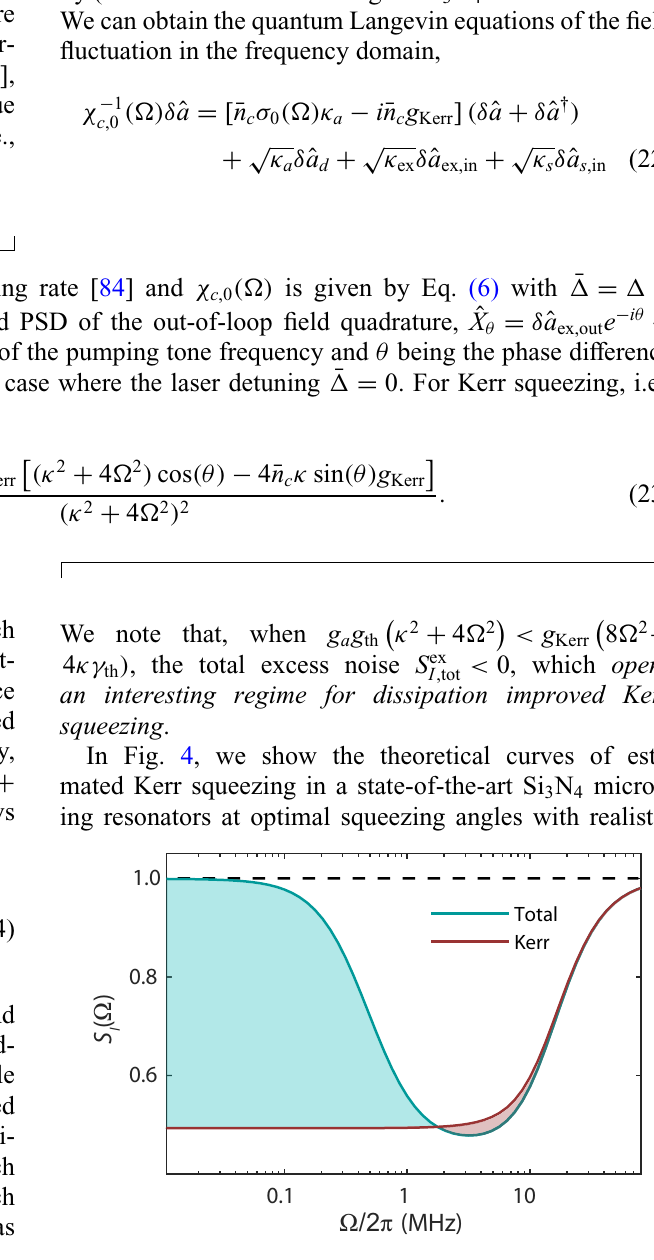
FIG. 4. Estimated Kerr squeezing with dissipative dynamics at optimal angles in a Si 3 N 4 microcavity. The noise spectral den- sity is normalized to the shot noise floor (black dashed line). The red curve corresponds to the case where the dissipative dynamics is absent, while the green curve corresponds to the case where Kerr nonlinearity and dissipative dynamics coexist. The green and red shade areas correspond to the excess noise and improved squeezing due to dissipative feedback. (Parameters: κ/ 2 π = 15 MHz, κ ex / 2 π = 8 MHz, κ a / 2 π = 6 MHz, κ s / 2 π = 1 MHz, / 2 π = 20 kHz, g / 2 π = − 0.05 Hz, g / 2 π = − 0.5 Hz, γ th Kerr a g th and ¯ n c = 10 7